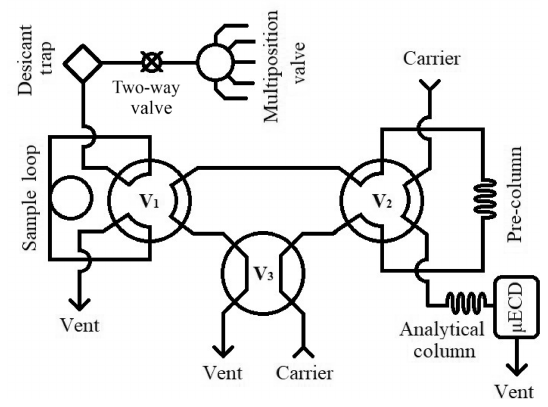
Figure 1. Schematic view of the analytical system for sample eval- uation. The system is shown in “back-flush” mode. V 1 represents Valve 1, V 2 represents Valve 2, and V 3 represents Valve